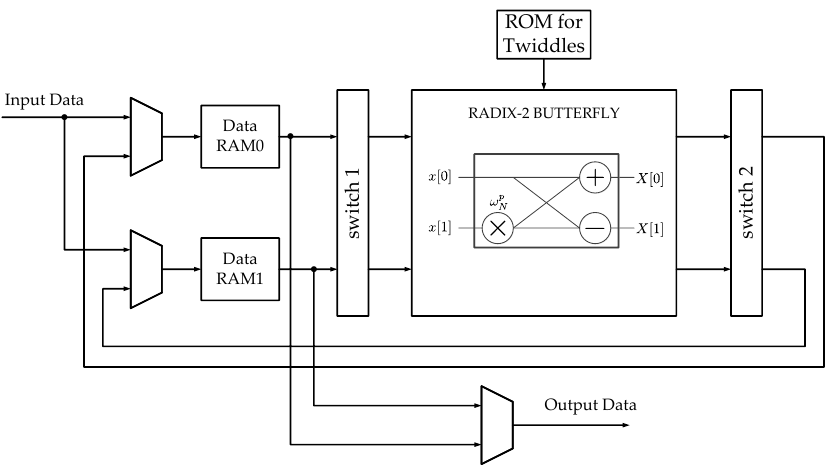
Figure 3. Xilinx Radix-2 Burst I/O architecture. RAM: random access memory; ROM: read only